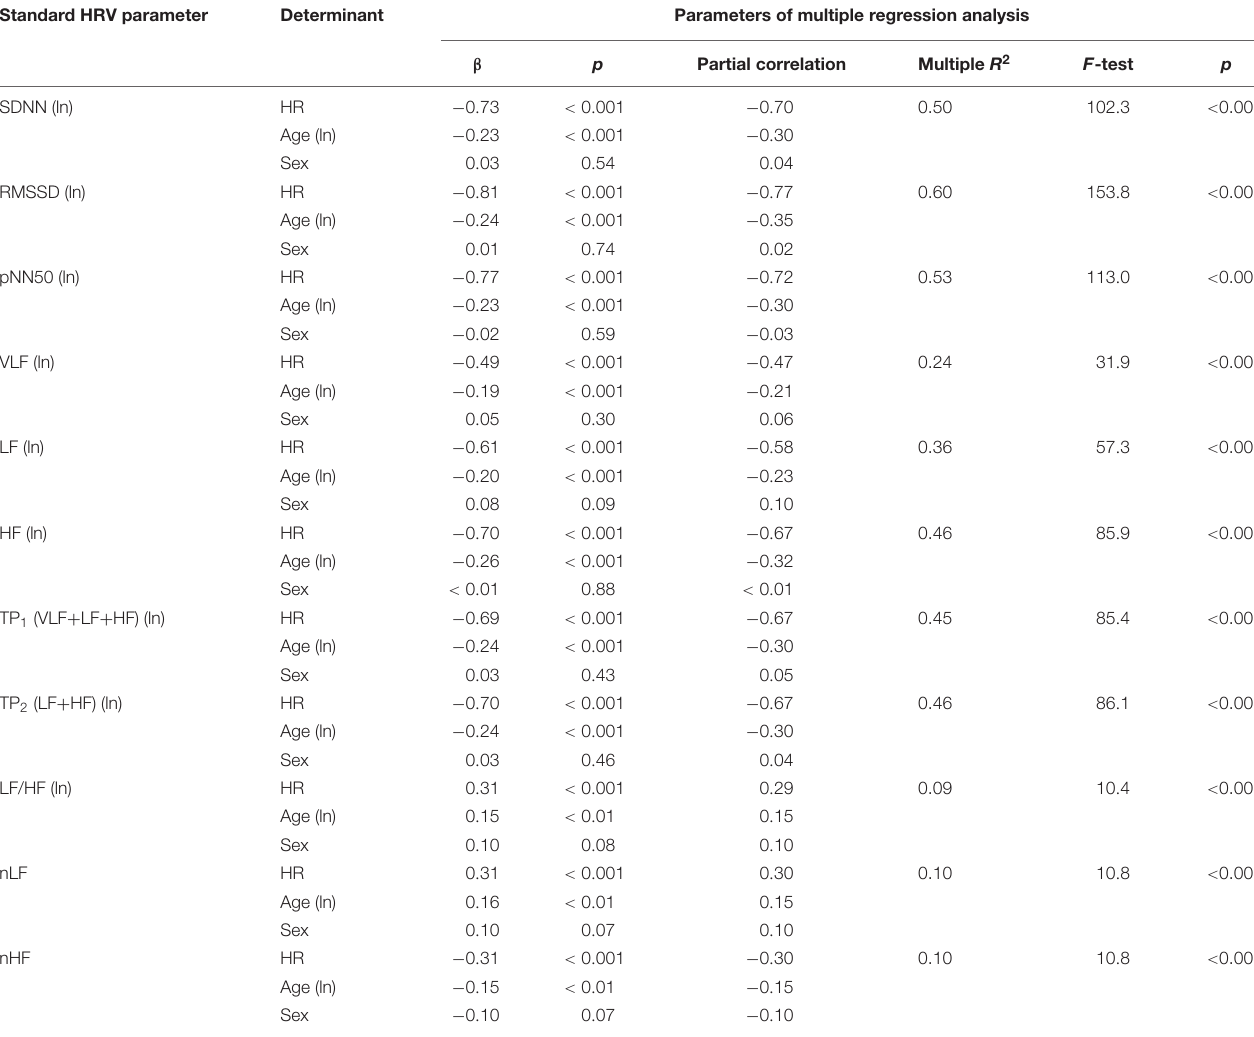
TABLE 2 | Determinants of standard time- and frequency-domain (calculated with FFT) HRV parameters. Standard HRV parameter Determinant Parameters of multiple regression analysis